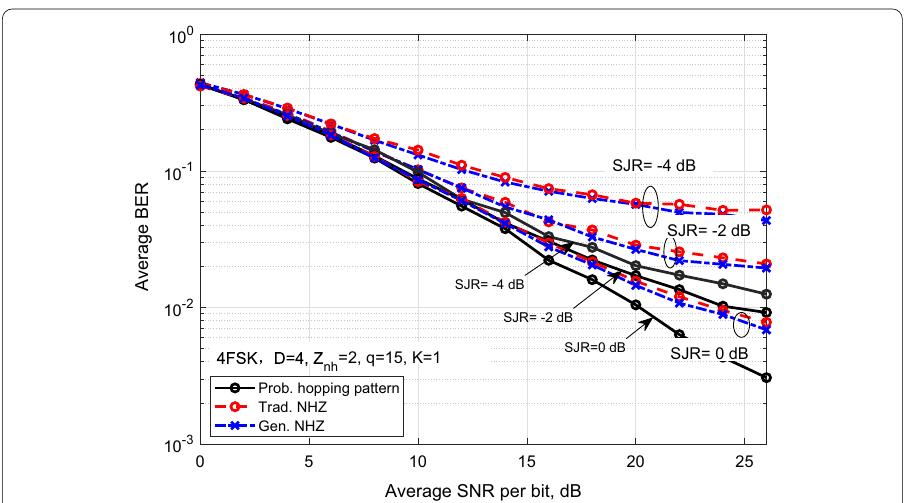
Fig. 5 The BERs of the channel-hopping-based wireless multi-node IoT networks for various SJR s with K =